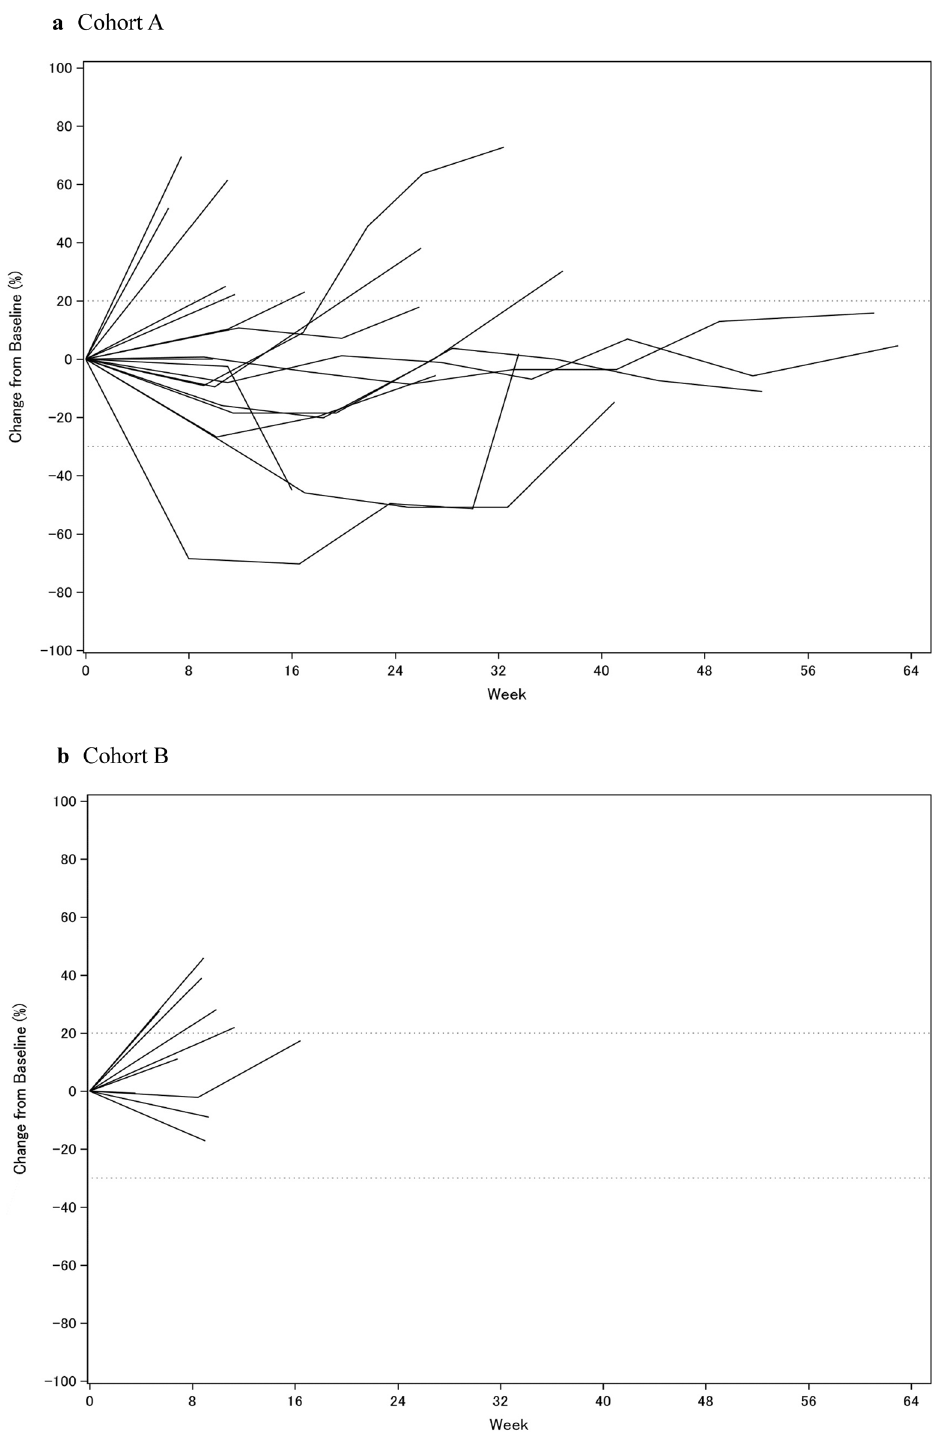
Figure 3. Change of sum of target lesions from baseline over time for each individual. ( a ) Cohort A, ( b ) Cohort